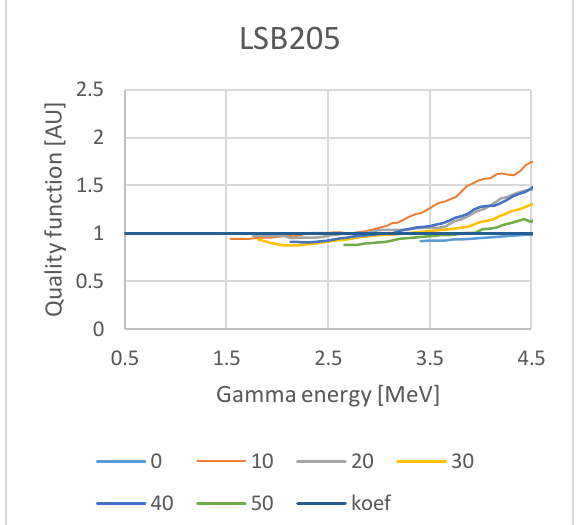
Fig. 2. FOM temperature dependencies of the LSB 205 scintillator